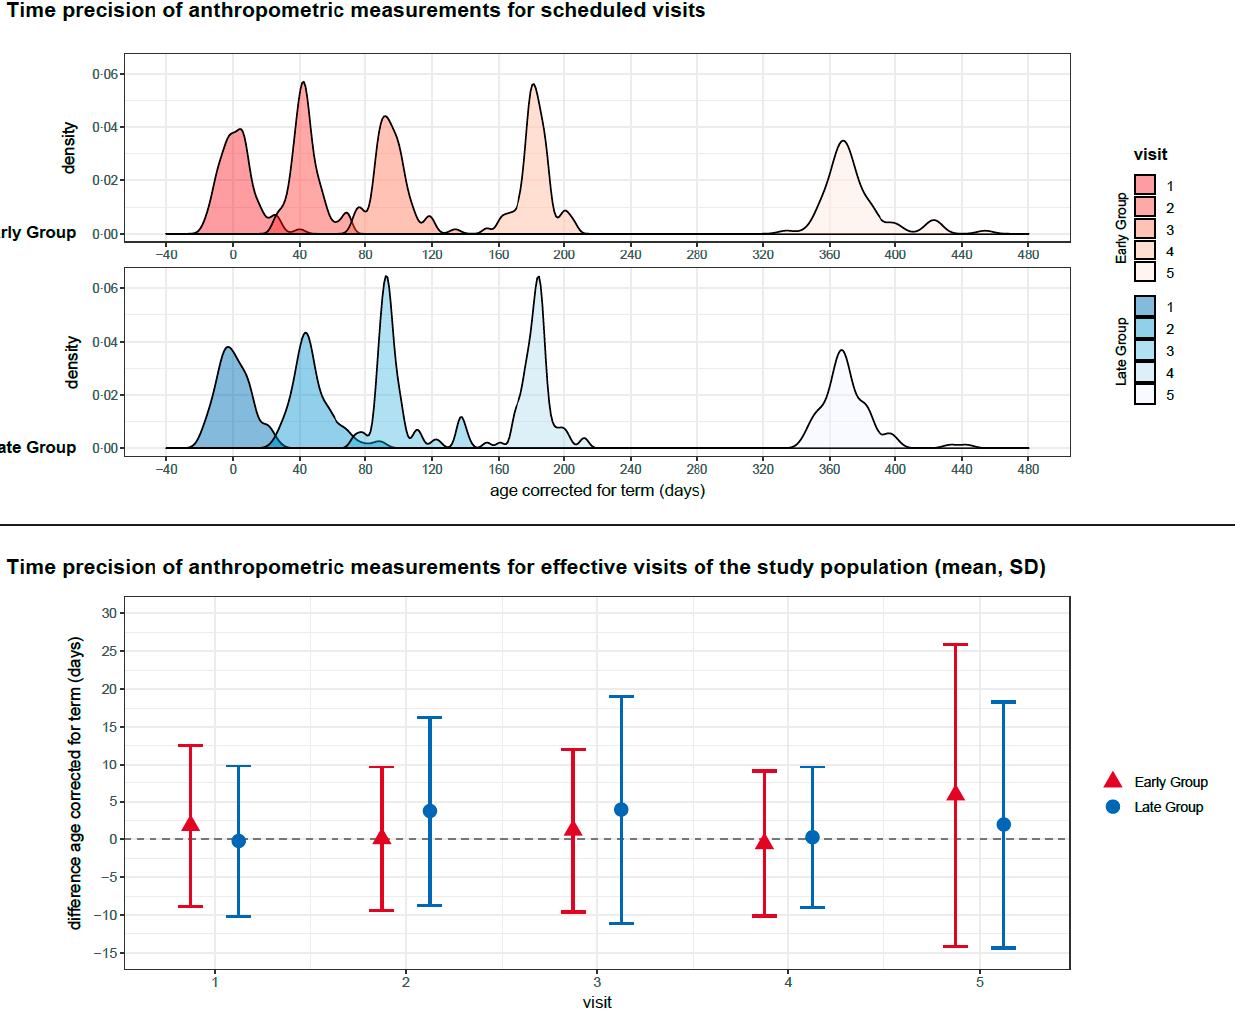
Figure 3. Time precision of anthropometric measurements. Plot A: The Kernel density plot shows the distribution of the time point of anthropometric measurement ( y -axis) of all study participants for the scheduled visits during the first year of life, corrected for term (x-axis). Plot B: Error bars for time point deviation (in days) of effective visits of the study population. Data are given in mean (SD).